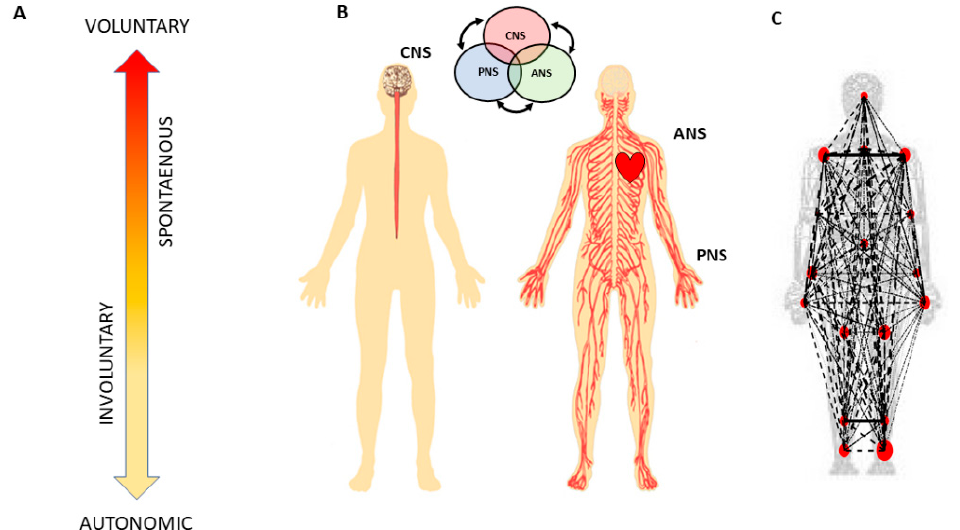
Figure 1. Defining quantitative aspects of agency for the study of embodied cognition. ( A ) A highly simplified schematics reflecting the phylogenetically orderly taxonomy of nervous system functions involving different levels of voluntary control (intent) ranging from deliberate to spontaneous movement segments, to involuntary motions and autonomic control. Levels correspond to three fundamental muscle types (skeletal for voluntary, smooth for involuntary, and cardiac for autonomic.) Multi-layered signals contributing from each of these layers are proposed to differentially contribute to the sense of action ownership and to the overall sense of agency via sensory consequences preceded by different levels of intent. ( B ) Contributions of the central and peripheral nervous systems (CNS and PNS, respectively), including the autonomic nervous system (ANS), can be tracked in a closed loop that helps the autonomous realization of intended thoughts into physical actions under volitional control. ( C ) Network connectivity analyses of kinematics and heart biorhythmic signals encompassing these levels of control enable the study of agency through objective quantitative methods.